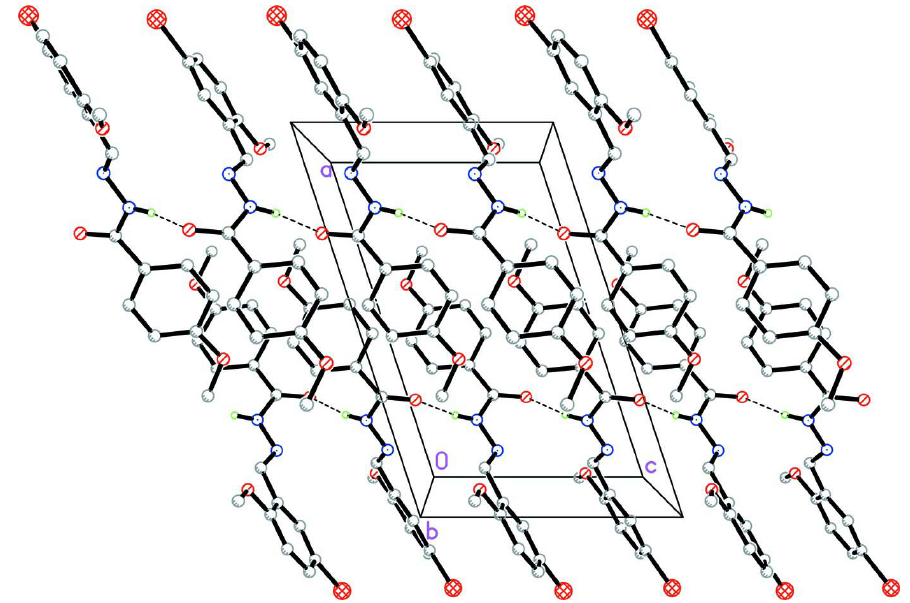
The molecular structure of (I), showing 30% probability displacement ellipsoids for the non-hydrogen atoms.